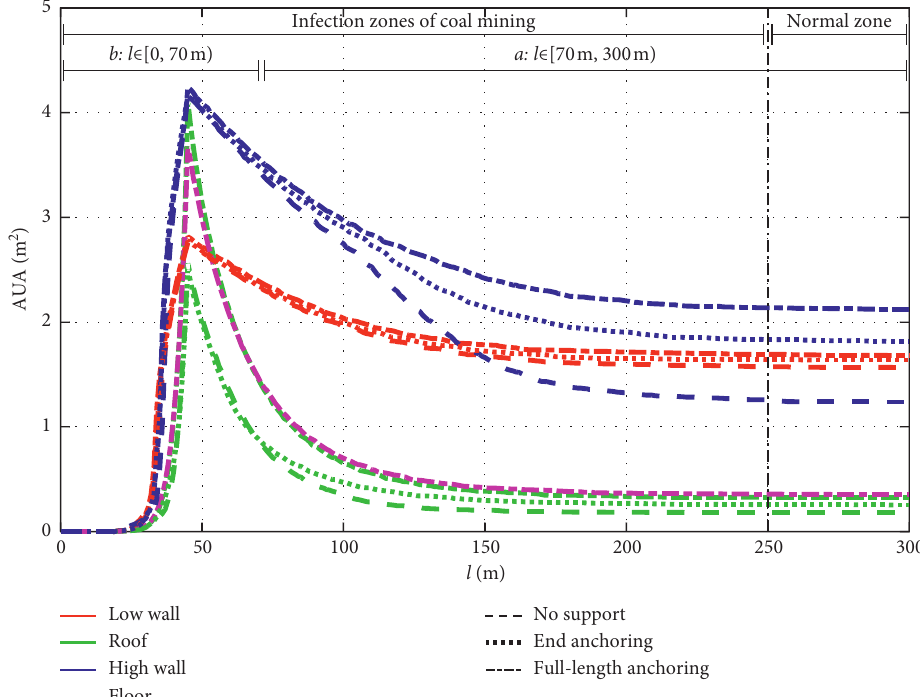
Figure 13: The curve of the AUA with no support, end anchoring bolt support, and full-length anchoring bolt support.